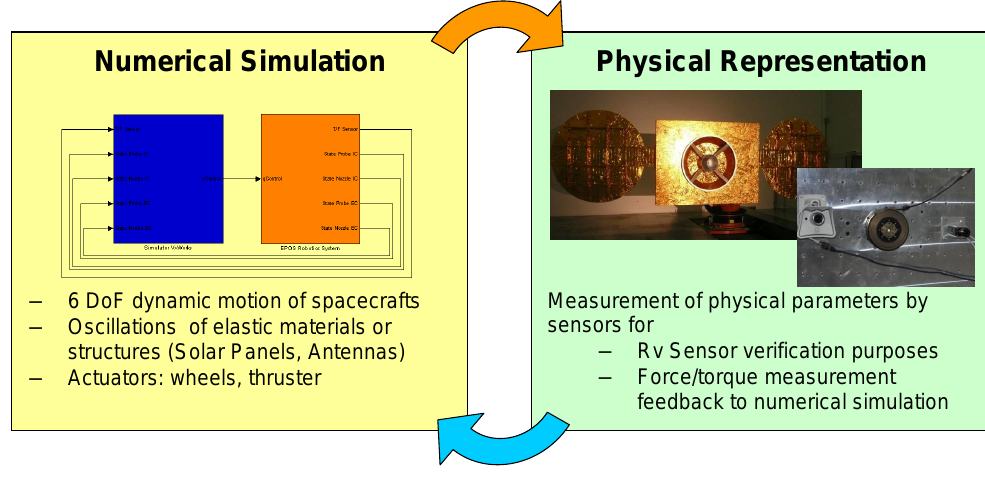
Figure 14: EPOS Hybrid Simulator - Concept